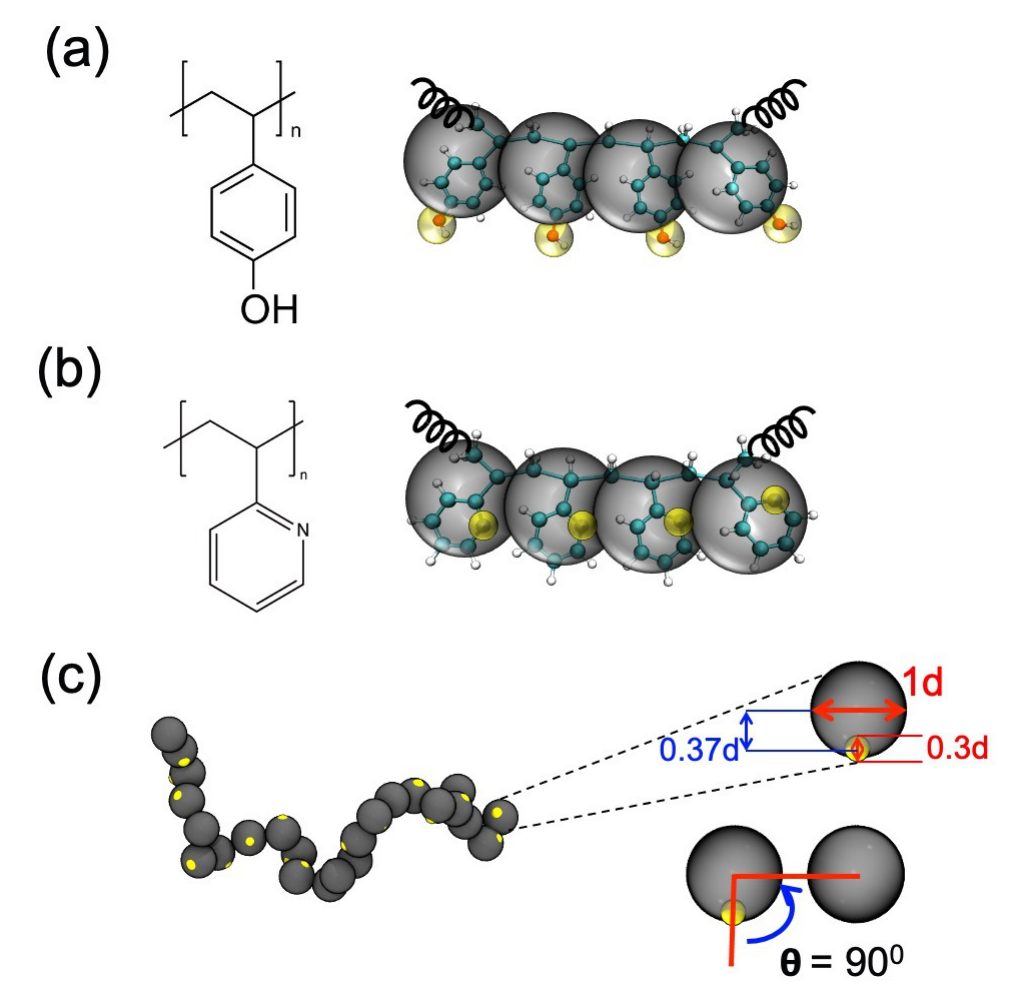
Figure 1. CG model for ( a ) poly(4-vinylphenol) (pvpH) and ( b ) poly(2-vinylpyridine) (pvpY). Each CG backbone (B) bead represents a monomer and is shown in gray color overlaid on the atomistic monomer representation. Each CG hydrogen bonding (H) bead is shown in yellow color. Following the work of Kulshreshtha et al. [109], the position and size of H bead with respect to the B bead are set to be the values shown in ( c ), where d represents the reduced unit of distance and is equivalent to 6 Å and 5.29 Å for pvpH and pvpY,